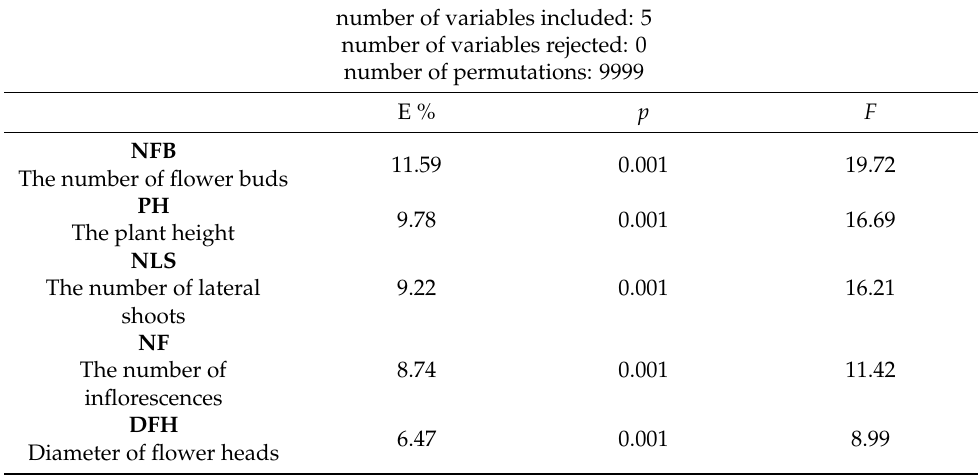
Table 4. Statistical parameters for the CCA (canonical-correlation analysis)